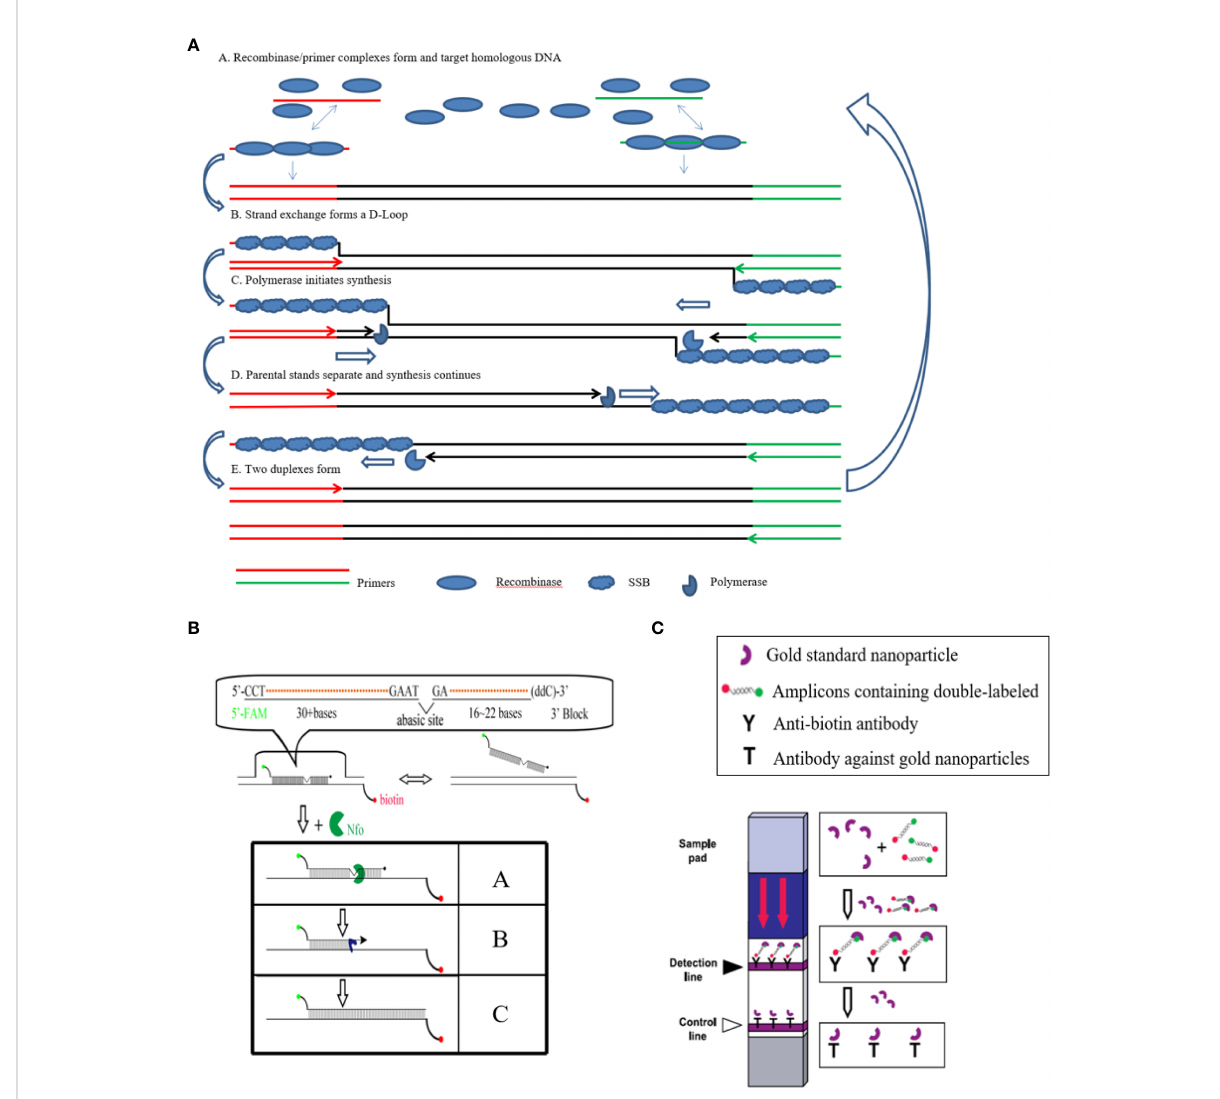
FIGURE 1 Principle of the LFD-RPA reaction. (A) : A Recombinase/primer complexes form and target homologous DNA; B. strand exchange forms a D- Loop; C. polymerase initiates synthesis; D. parental stands separate and synthesis continues; E. two duplexes form; (B) : A. Nfo enzyme recognizes the THF site in the ampli fi ed double-stranded sequence containing a 5 ’ -FAM tag, an internal THF and a 3 ’ protective group, and shears it to form a polymerase Bsu-catalyzed extended 3 ’ hydroxyl substrate. B. The remaining part of the probe extends to fi x its binding to the corresponding chain of the biotin-containing tag. C. Finally completes the double-labeled amplicon containing biotin and FAM; (C) : In the sample loading area of the LFD test strip (Sample loading pad) containing gold standard nanoparticles with a speci fi c antibody with FAM, can be combined with the product containing the corresponding antigen label, through the test strip on the two indicator lines of the antibody, one is the detection line, which is coated with the antibody of the product biotin, can intercept the double antigen label product that binds to the gold standard nanoparticle, thus showing red, indicating that the product has a double antigen label; the other is the control line, it is coated with an antibody with a FAT antibody on a gold standard nanoparticle, which can intercept the gold standard nanoparticle, thus showing a red color, indicating the effectiveness of the test